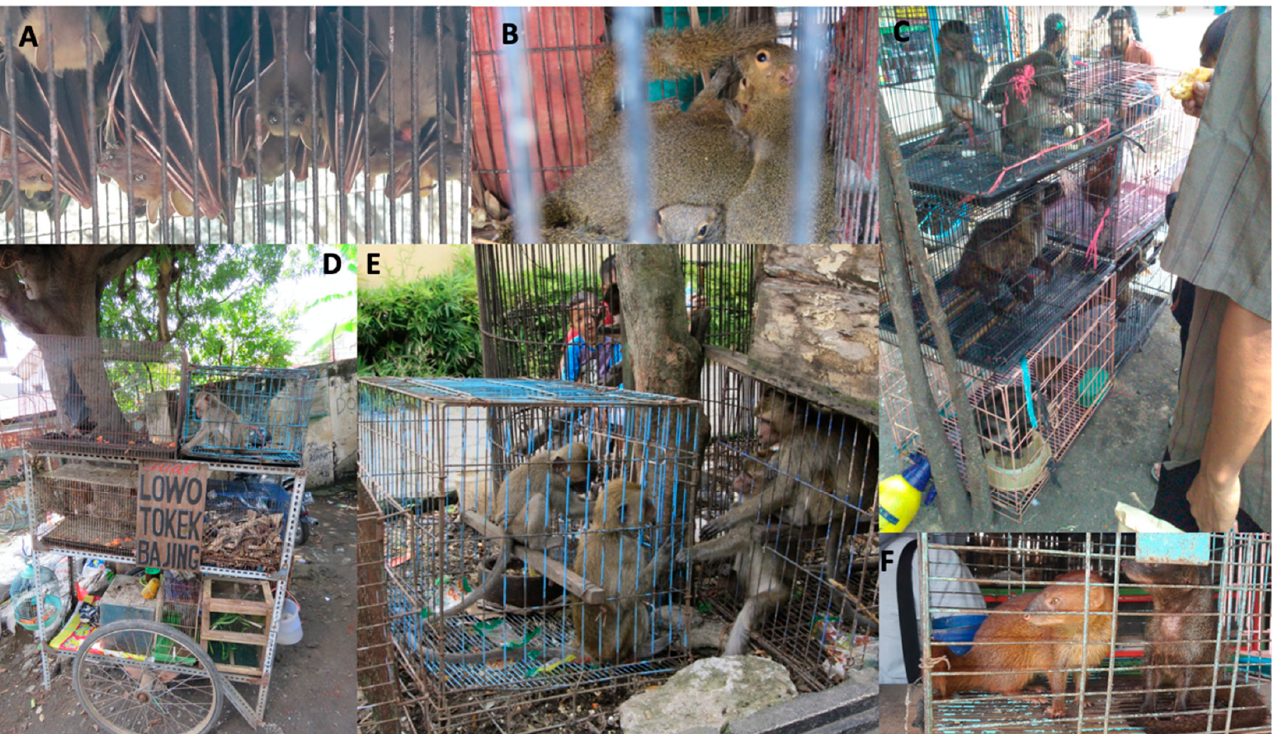
Figure 1. Trade in wild mammals in Java, Indonesia. ( A ) Indonesian short-nosed fruit bat ( Cynopterus titthaecheilus ); ( B ) plantain squirrel ( Callosciurus notatus ), ( C ) long-tailed macaque ( Macaca fascicularis ) and Asian palm civet ( Paradoxurus hermaphroditus ); ( D ) long-tailed macaque and giant fruit bat ( Pteropus vampyrus ); ( E ) long-tailed macaque; ( F ) Javan mongoose ( Urva javanica ).